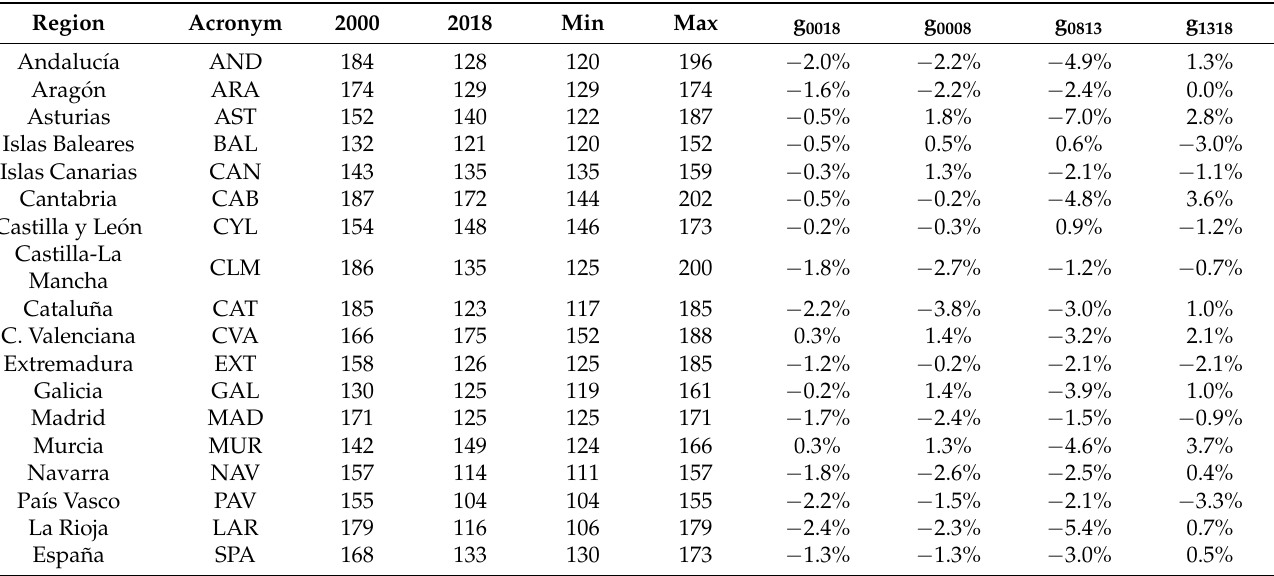
Table 1. Descriptive analysis. Household consumption of water